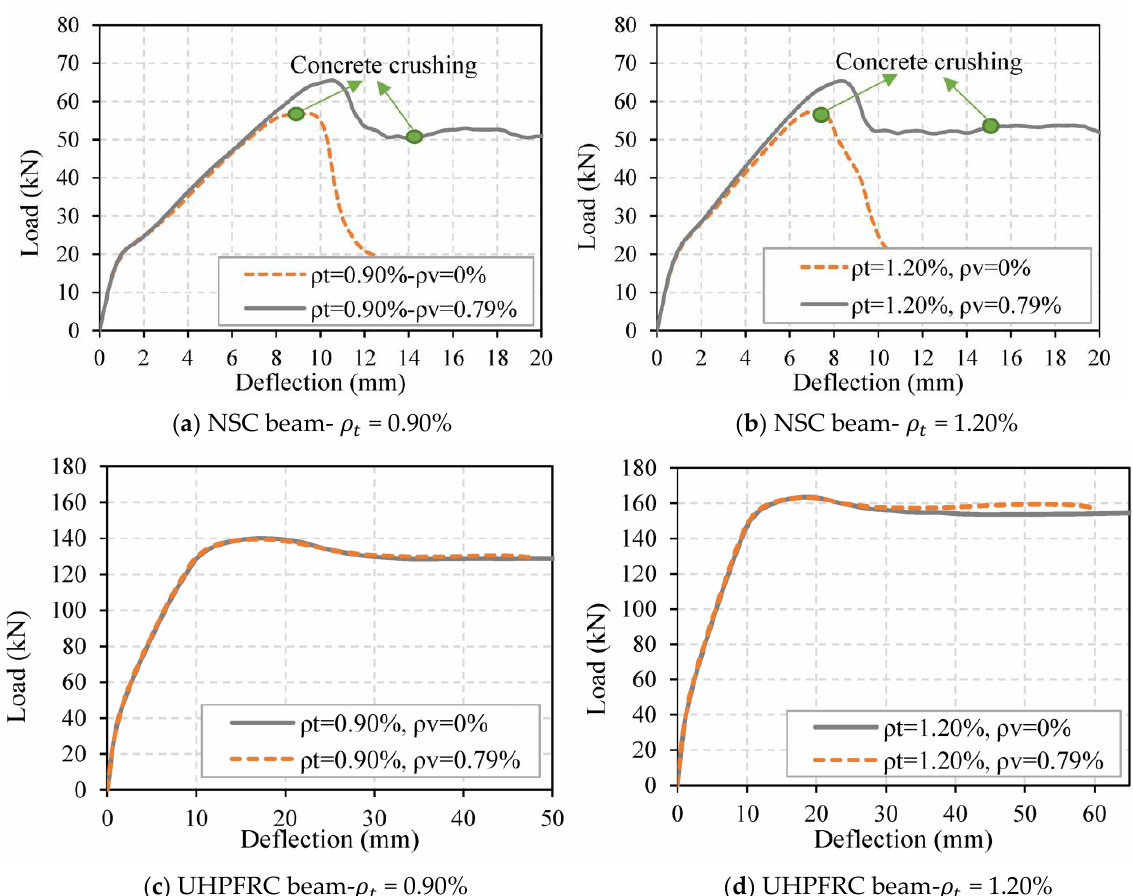
Figure 10. Load deflection response of NSC and UHPFRC beams (with cross section similar to U-B4 and U-B6) with reinforcement ratios of 0.90% and 1.20% with and without stirrups.